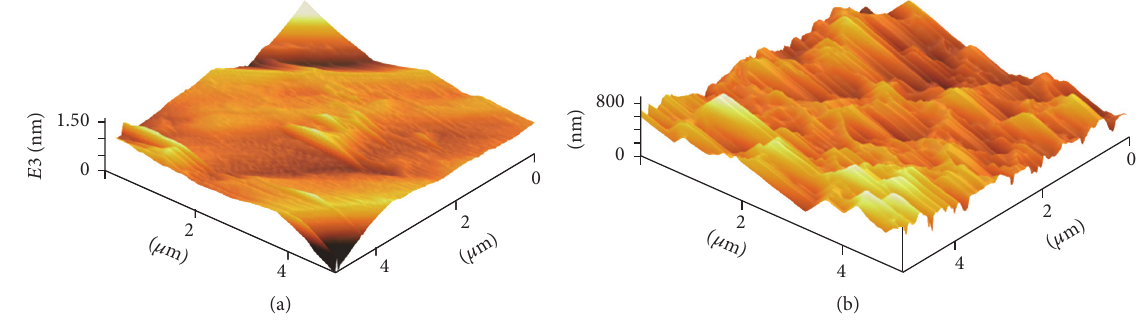
Figure 2: AFM 3D height image of (a) SPEEK and (b)